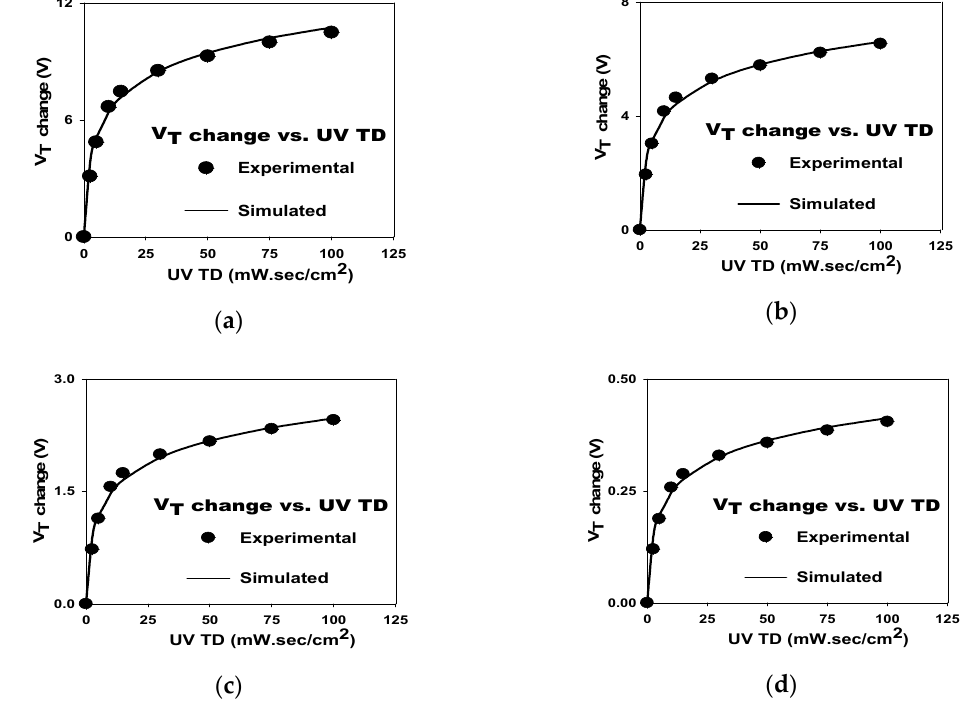
Figure 11. The model of V T change as a function of UV TD for an SAHAOS-T3 capacitor device ( a ) under PGV 30V; ( b ) under PGV 20V; ( c ) under PGV 10V; ( d ) under PGV 5V.